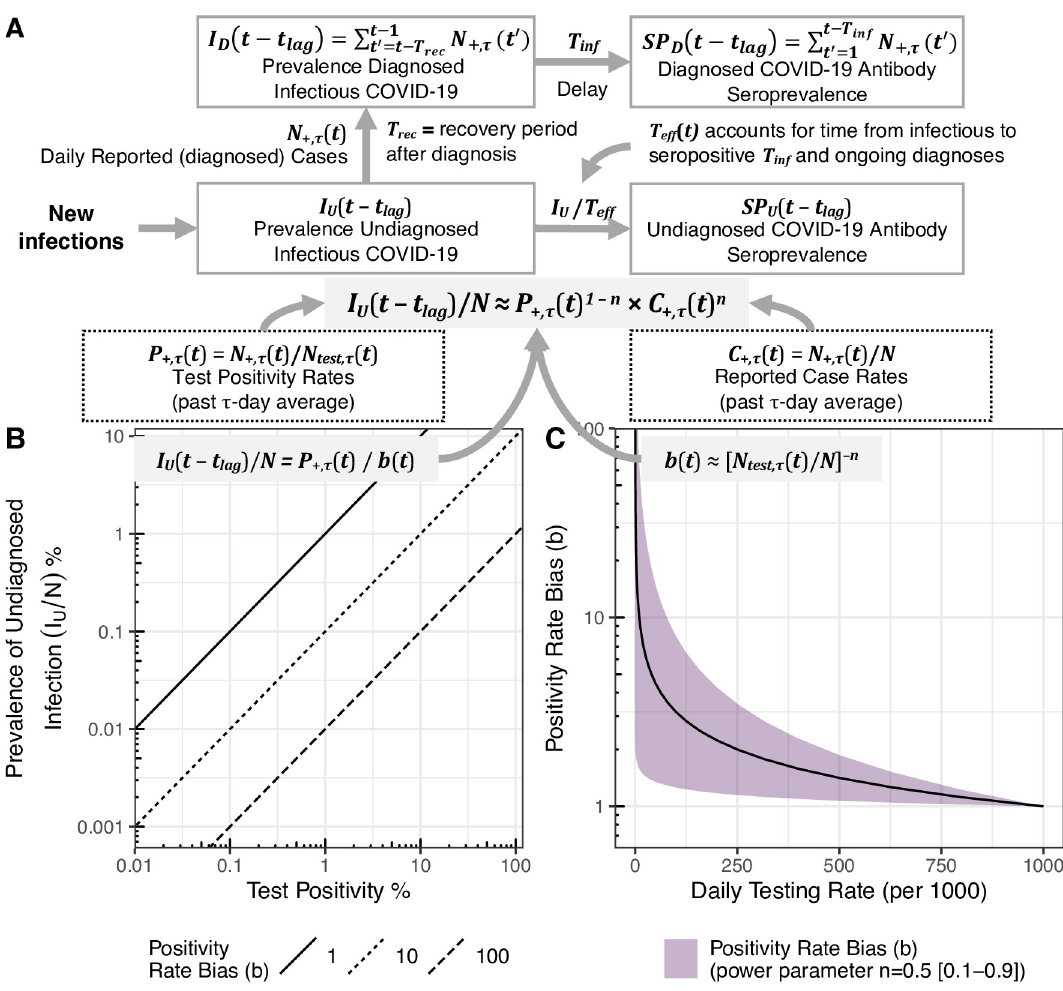
Fig 1. Conceptual model for relationship between test positivity, prevalence of infection, and testing rate. (A) Compartmental representation of how the relationships between new infections, undiagnosed and diagnosed prevalence ( I seroprevalence ( SP and SP ) are modeled for each state, given a bias with power n . All observational inputs are the past τ -day U D averages of number of positive tests N + , τ ( t ) and number of tests performed N test , τ ( t ), the corresponding test positivity rate P + , τ ( t ) and ( t ), and the state population size N . For diagnosed prevalence and seroprevalence, the observational input is the reported case rate C + , τ daily reported cases N + , τ , and the model parameters are the recovery time after diagnosis T rec and the time from infection to seropositivity T . For undiagnosed prevalence and seroprevalence, our model assumes the test positivity rate is correlated to delayed inf undiagnosed disease prevalence with a bias parameter b ( t ) modeled as a negative power function of the testing rate b ( t ) = [ N test , τ ( t )/ N ] – n (Eq 2). The additional parameters consist of the power parameter n and the initial (missed) seroprevalence SP o . The effective rate parameter 1/ T eff is time-dependent, and accounts for both T inf and ongoing diagnoses so as to not “double count.” Prevalence and seroprevalence are evaluated with a lag time t lag , assumed equal to half the averaging time τ /2. In (B ), the diagonal lines represent different values of the bias parameter. In (C), the relationship between testing rate and bias parameter represented by Eq (4) is illustrated. Here the shaded region represents different powers n ranging from 0.1 (lower bound bias) to 0.9 (upper bound bias), the solid line represents n = ½